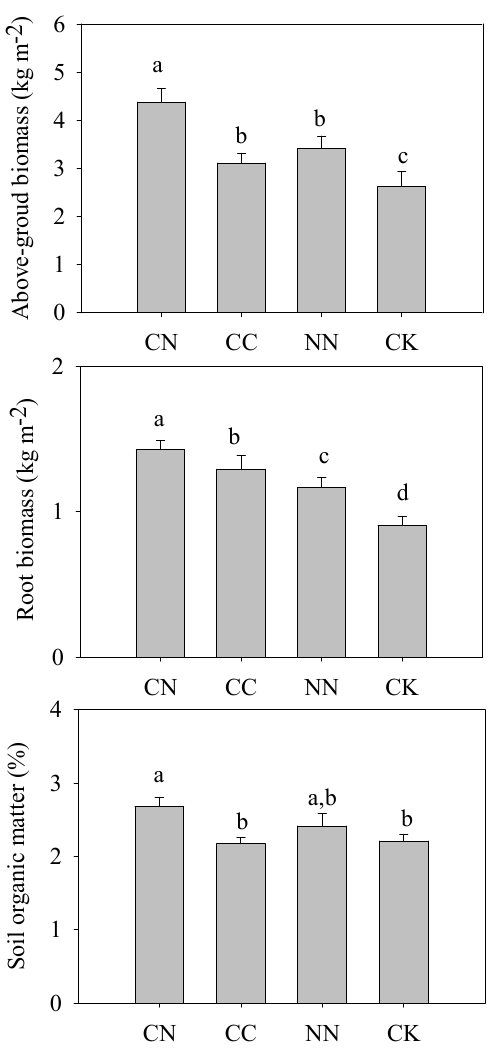
Fig. 4. Above-ground biomass and root biomass in January 2008, and soil organic matter in November 2008 under different CO 2 and N treatments. Error bars are standard deviations, which showed the dispersion among open-top chambers employed for each treatment. n = 3 for the CN and CC treatments, n = 2 for the NN treatment and CK. Different letters denote significant difference between treat- ments. Significant level is set at α = 0 . 05. The treatments are: CK = control, NN = high N, CC = elevated CO 2 , CN = elevated CO 2 + high